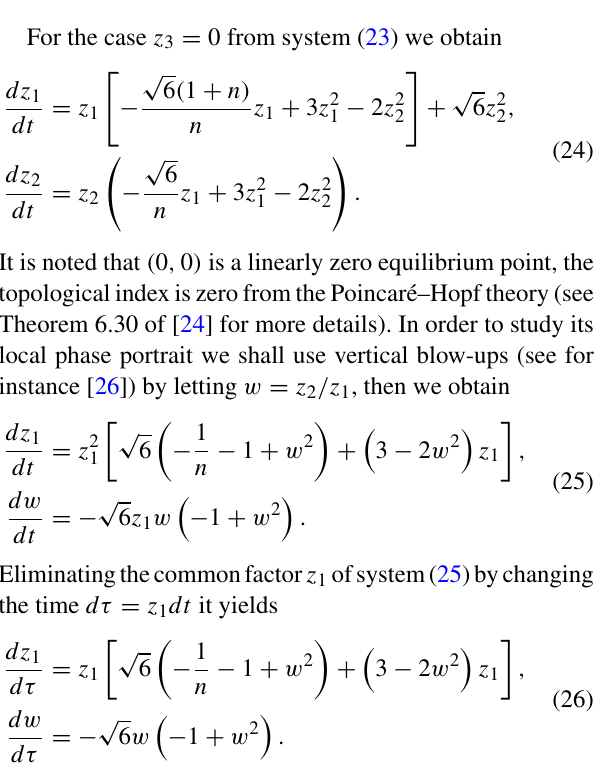
portraits of system (7) in the region R 1